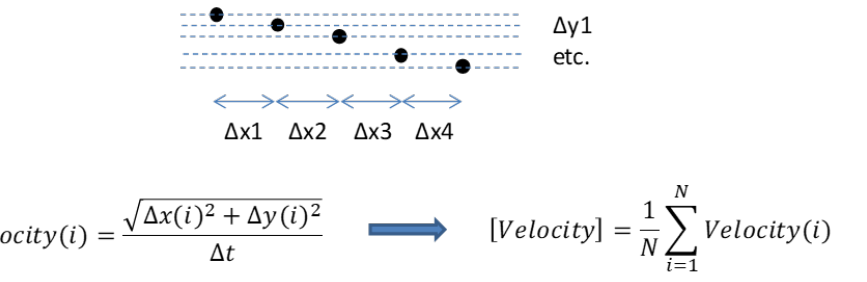
Figure 4. Close up of the chip. ( a ) Face-to-face electrode design. ( b ) Zig-zag electrode design. ( c ) DC chip design. The lift-off process results in well-defined structures. ImageJ was used to measure the distances between the electrode tips in both designs. For the face-to-face design, the mean distance between the electrode tips is 2.53 ± 0.10 µm, while for the zig-zag structure, the minimum distance between the electrode tips is 1.79 ± 0.18 µm. The DC electrodes are 3.24 ± 0.14 µm. All results are based on 10 different measurements. 3.2. Numerical Simulations The chip’s geometrical requirements presented in Section 2.1 were based on numer- ical simulations performed on a much wider channel (150 µm) and with electrodes at an- gles of 30, 45, and 60 degrees relative to the direction of the channel width, located on the bottom and top of the channel. The results of these simulations, performed for particles of 30 nm in diameter, in a channel with a flow of 1 µL/h, and with single, double, or triple face-to-face electrodes per electrode arm, plotted as described in Section 2.2 and Figure 2 (for the case of a triple electrode), are shown in Figure 5. The graphs show that only the particles situated in the central 40 – 60 µm of the channel width are influenced by the elec- tric field and that electrodes at a 60-degree angle result in a larger displacement than those at 30 or 45 degrees. We can also see that as the channel height becomes smaller (plotted